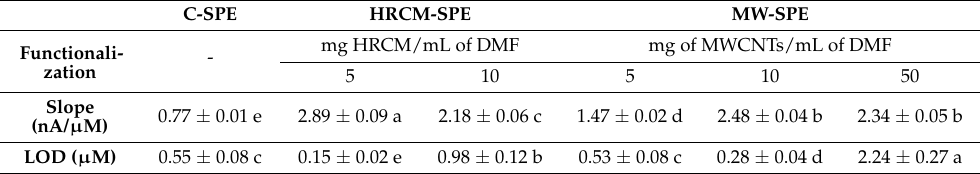
Table 1. Slope of the AA calibrations (nA/ µ M) and LOD ( µ M) of the sensors calculated for C-SPEs, HRCM-SPEs functionalized with 5 and 10 mg/mL of HRCM/DMF suspension, and MW-SPEs functionalized with 5, 10, and 50 mg/mL of MWCNT/DMF suspension.